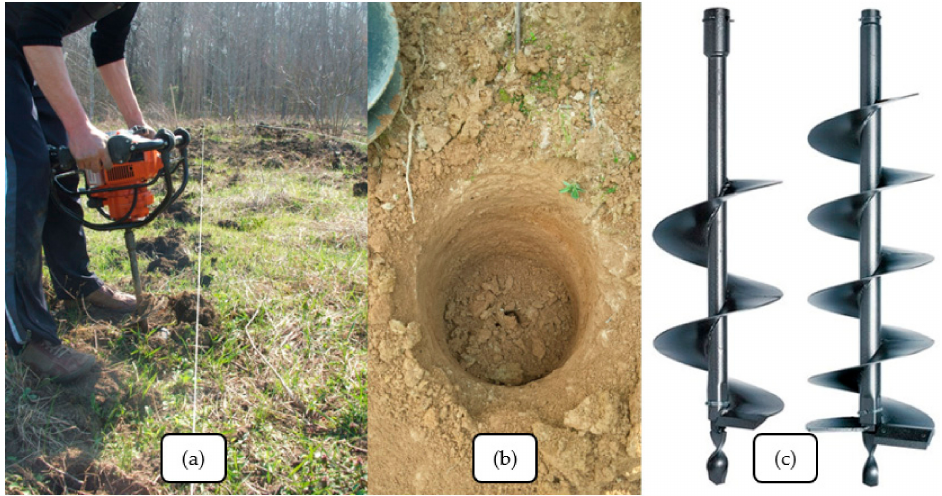
Figure 2. Example of pit drilling in one of the field tests ( a ), using either 150-mm drills (D 150 ) or 200-mm drills (D 200 ) ( c ), and an example of the resulted pit ( b